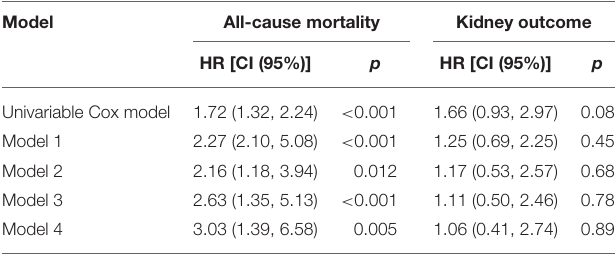
TABLE 5 | Association of late-onset LN with all-cause mortality and kidney mortality. Model All-cause mortality